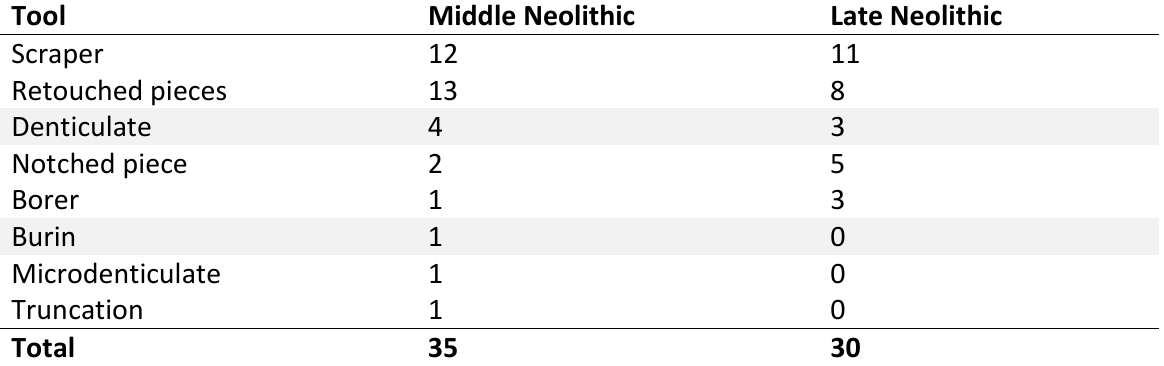
Table 7. Proportion of tools by